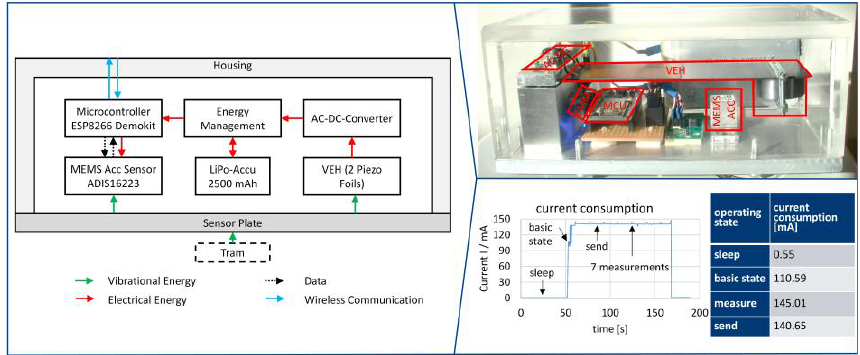
Figure 7. Overall design of the wireless and energy self-sufficient sensor network node and measured current consumption in the four operating states.